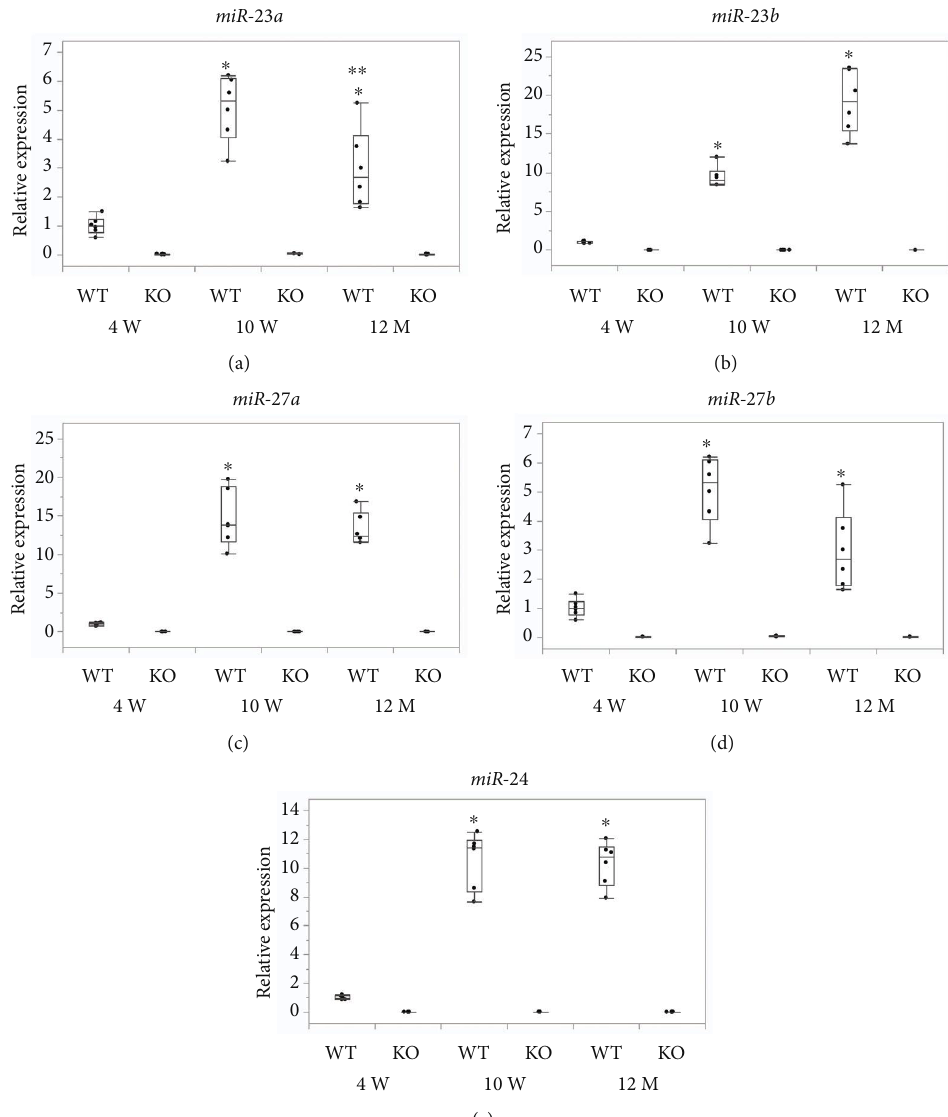
Figure 2: Expression levels of the miR-23-27-24 cluster miRNAs in the spinal cord of wild-type mice at di ff erent ages. (a) miR-23a, (b) miR- 23b, (c) miR-27a, (d) miR-27b, and (e) miR-24, n = 4 per group. The expression of all miRNAs was signi fi cantly higher in 10-week-old mice compared to 4-week-old mice. miR-23a expression was lower in 12-month-old mice compared to 10-week-old mice. ∗ Compared to 4-week- old. ∗∗ Compared to 10-week-old, p < 0 : 05